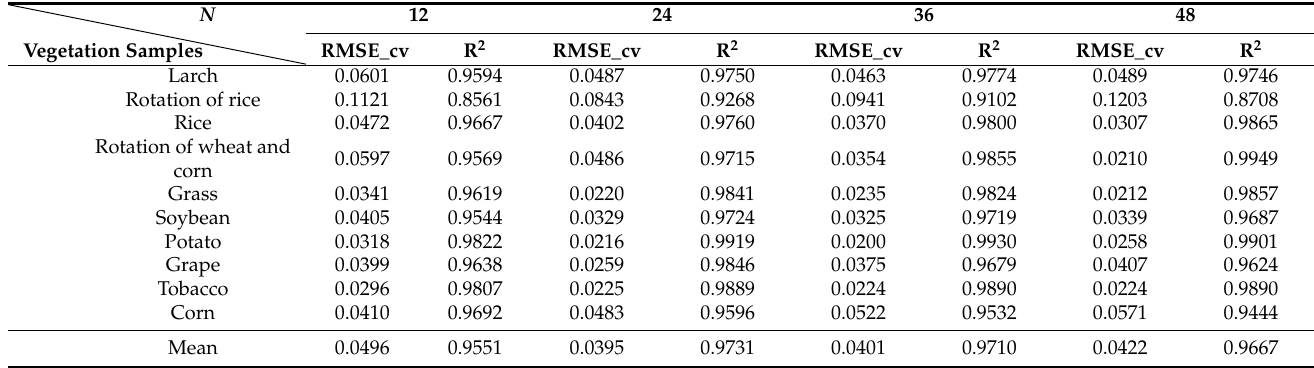
Table 3. The lowest RMSE_cv and corresponding R 2 of different N of typical vegetation samples.